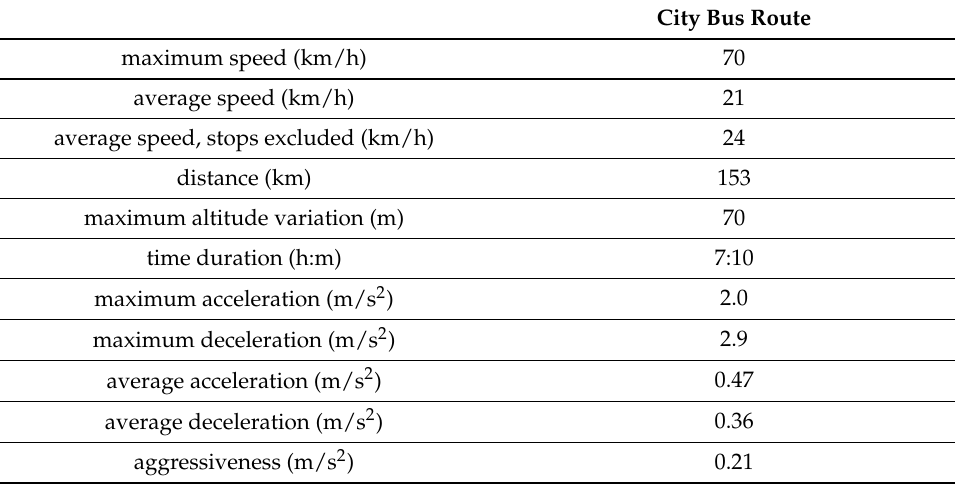
Table 1. The drive cycle in short—three full cycles.